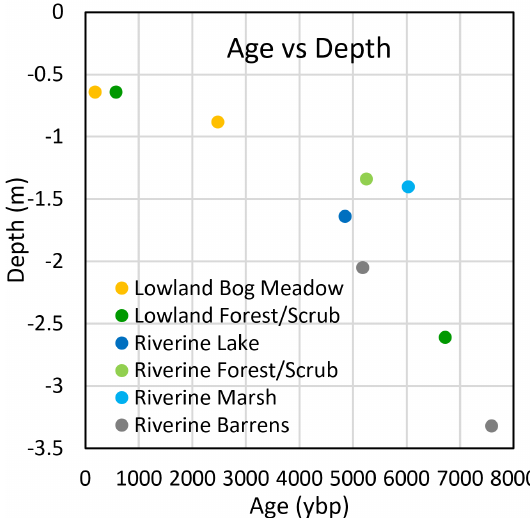
Figure 15. Radiocarbon age (ybp) versus depth by ecotype, Gosling Lake, Alaska. Age error bars were too small (35–54 years) to show.